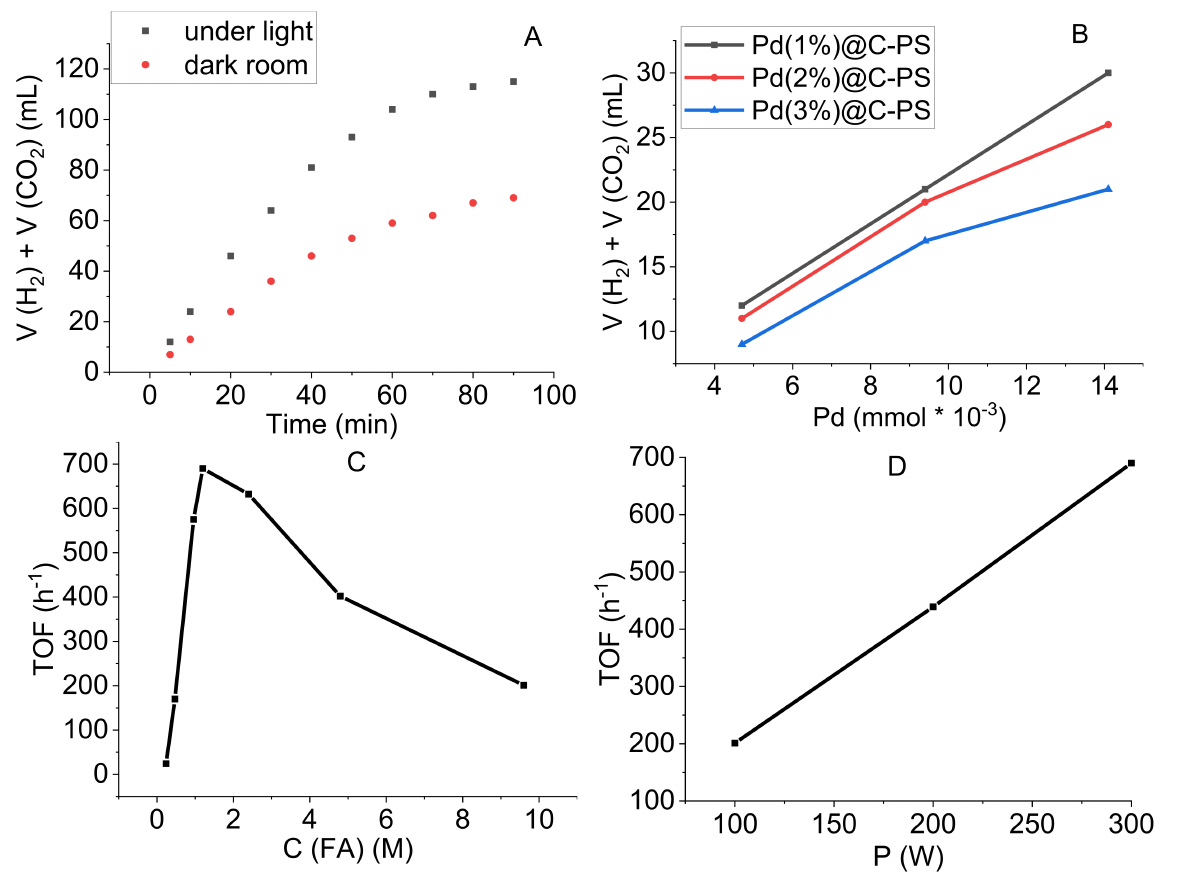
Figure 9. FA degradation toward H 2 /CO 2 production: ( A ) Volume of the produced gases (H 2 + CO 2 ) as a function of reaction time, ( B ) Volume of the produced gases (H 2 + CO 2 ) as a function of Pd concentration at 10 min, ( C ) Catalytic TOF of the reaction as a function of FA concentration at 10 min, and ( D ) Catalytic TOF of the reaction as a function of light power at 10 min.